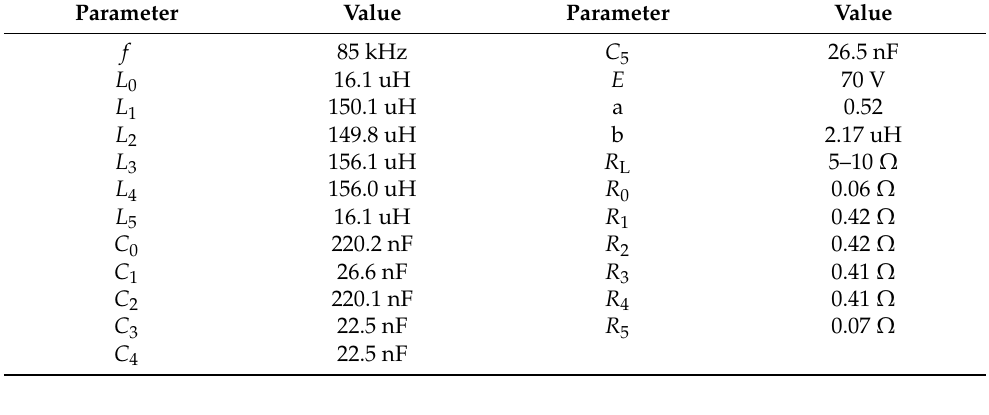
Table 1. Experimental parameters of the system.